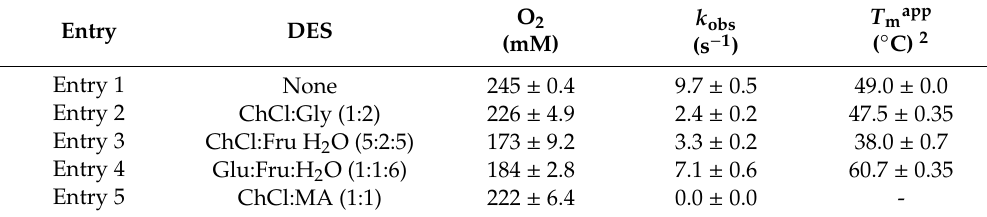
Table 4. Effect of DESs (60% v/v ) on solubility of dioxygen and activity of HMFO with alcohol 5a 1 . Table 4. E ff ect of DESs (60% v / v ) on solubility of dioxygen and activity of HMFO with alcohol 5a 1 . Entry DES